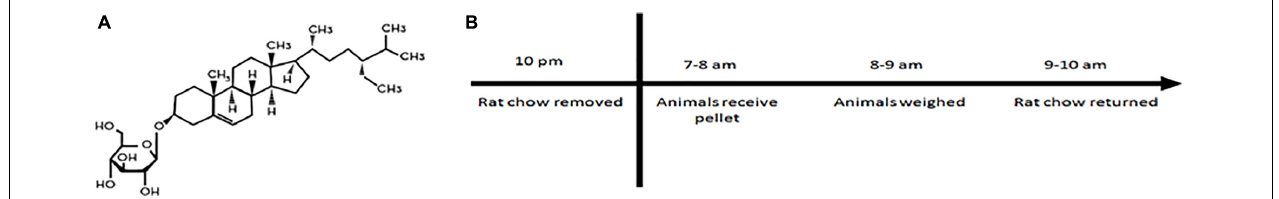
FIGURE 1 | (A) Structure of β -sitosterol β -D-glucoside (BSSG). (B) Daily feeding schedule for BSSG administration.